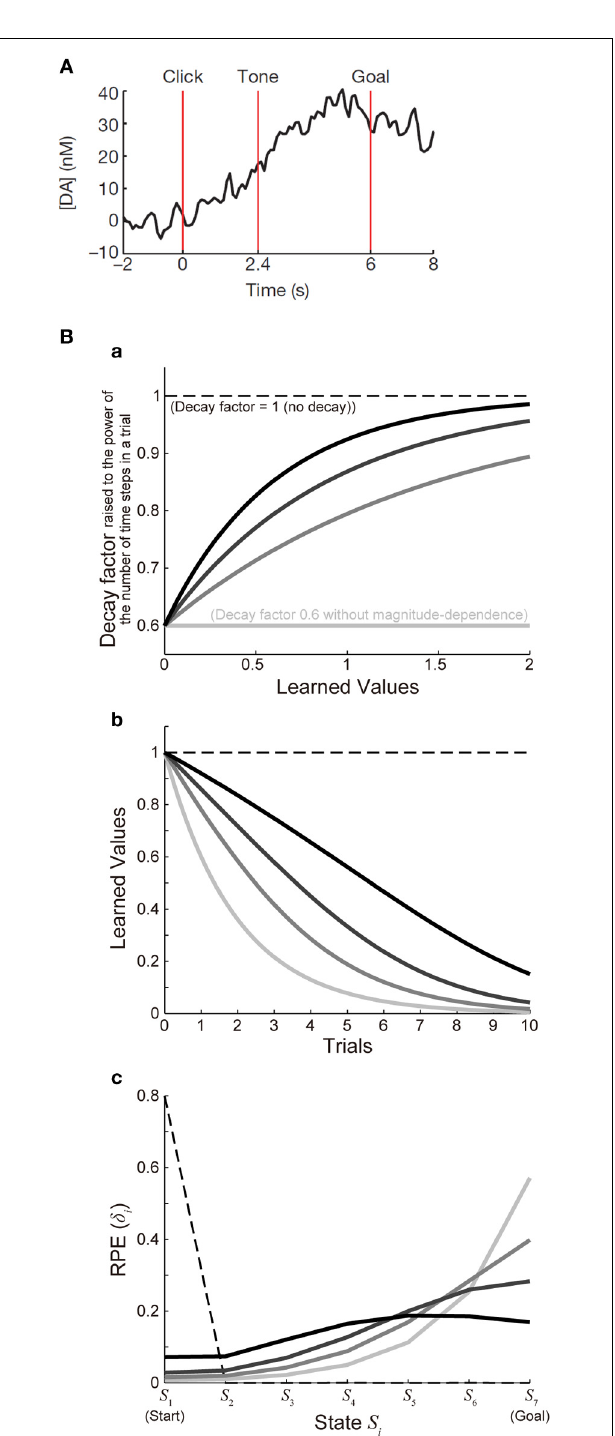
FIGURE 3 | Decay of learned values with magnitude-dependent rate leads to sigmoidal ramping of RPE resembling the observed DA ramping. (A) was reprinted by permission from Macmillan Publishers Ltd: Nature (Howe et al., 2013), copyright (2013). (A) DA ramping in the ventromedial striatum observed in the experiments (Howe et al., 2013). (B) (a) Presumed magnitude-dependence of the rate of decay of learned values raised to the power of the number of time steps in a trial.